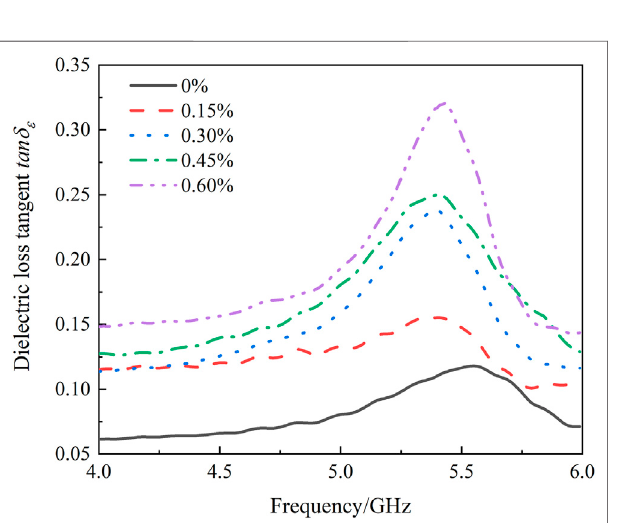
FIGURE 6 | Conductivity loss tangent curve with